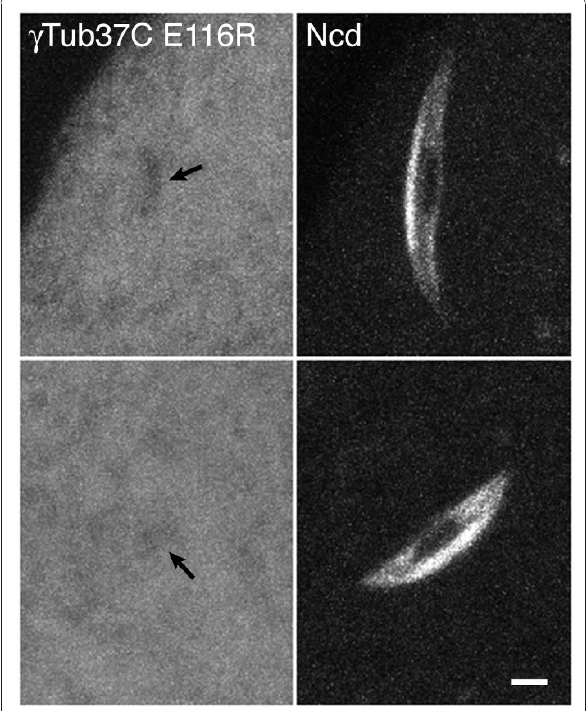
Figure 3 Mutant g Tub37C in oocytes . g Tub37C E116R-GFP, mutated in a conserved g Tub37C residue, is present in the cytoplasm, but does not localize to oocyte MI spindles (left). Dark regions (arrows) correspond to the condensed MI chromosomes [23]. Spindles detected with Ncd-mRFP1 (right). Bar, 3 μ